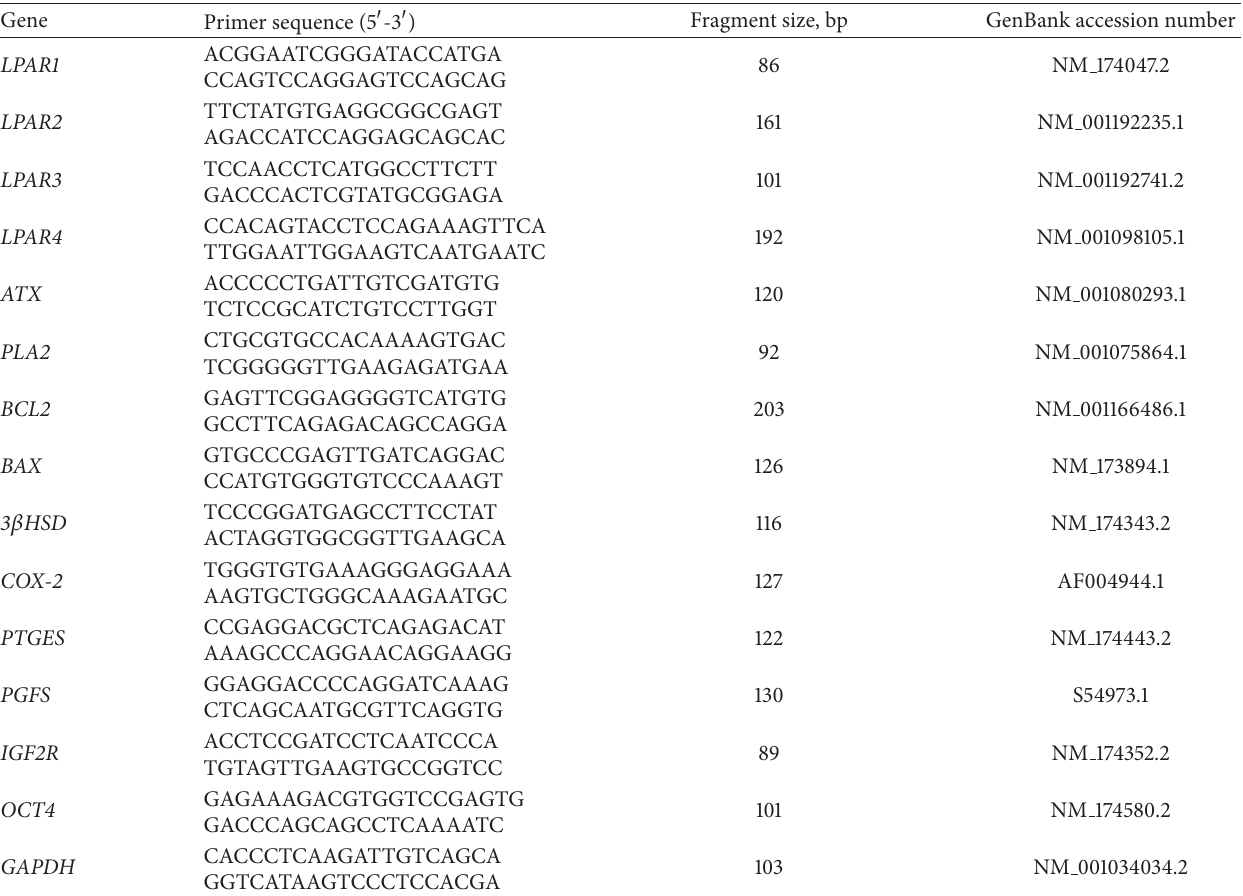
Table 1: Target genes and primer pair sequences used in